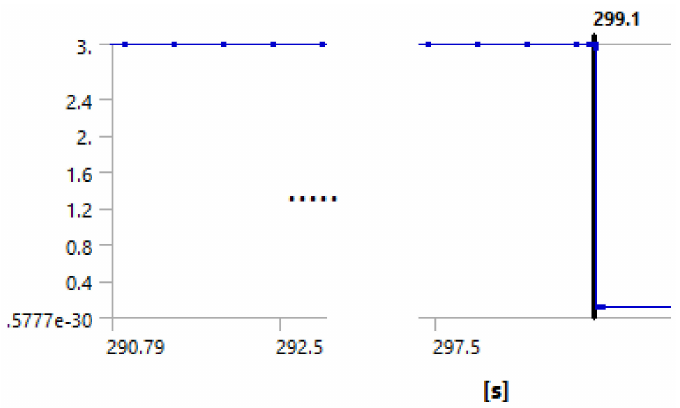
Figure 9. Debonding moment observed on the contact status showing abrupt change of contact status by the blue line at time stamp 299.1 s.